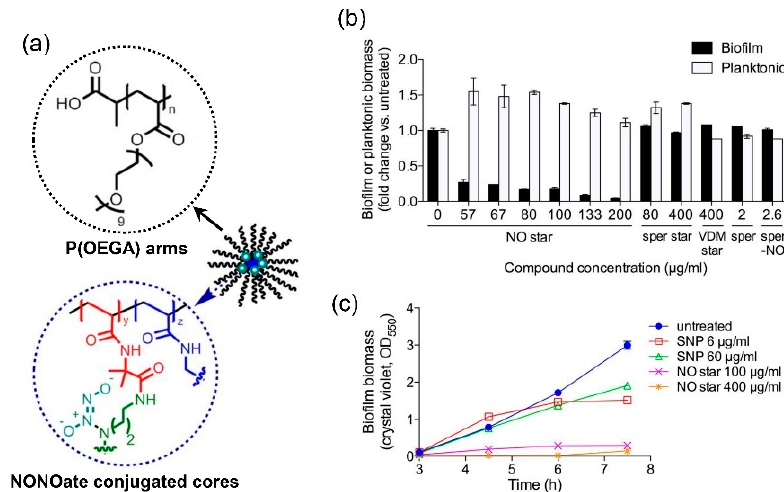
Figure 4. Structure and antibacterial property of NONOate conjugated star polymers. ( a ) The structure of NONOate conjugated star polymers, with P(OEGA) arms and NONOate conjugated cores. ( b ) Biofilm or planktonic biomass after treatment with NONOate conjugated star polymers, which showed dose-dependent prevention of biofilm formation. In contrast, the control groups, star polymers without NONOate conjugation, spermine and NONOate conjugated spermine showed no obvious preventing e ff ect against biofilm formation. ( c ) Biofilm biomass after treatment of spontaneous NO donor sodium nitroprusside (SNP) and NONOate conjugated star polymers, by crystal violet staining (OD550). Reproduced with permission from [56]. Copyright 2014, American Chemical